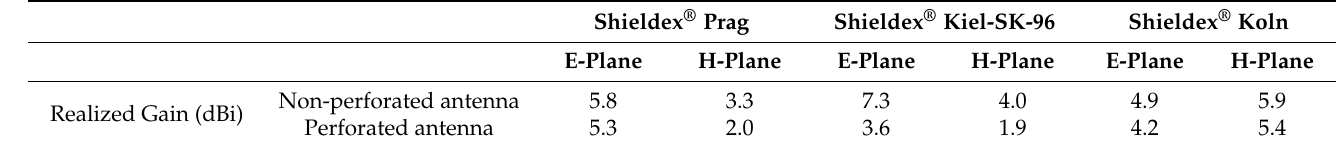
Table 6. Measured realized gains of non-perforated and perforated